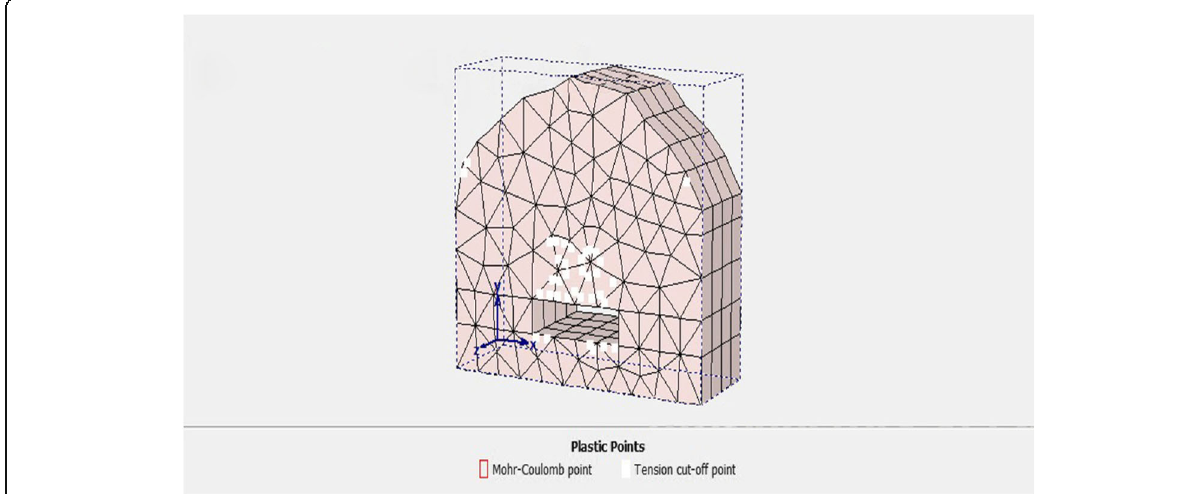
Fig. 31 Plastic Points in the ceiling and sidewalls of northern Chamber. PLAXIS 3D